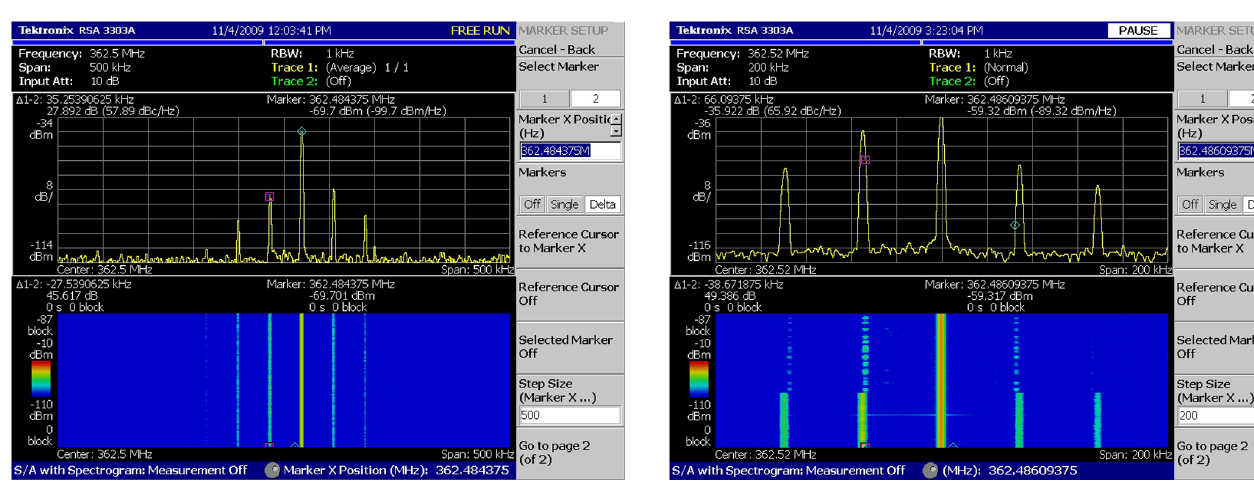
FIG. 1. Positron 118th rf harmonic with synchrotron side-